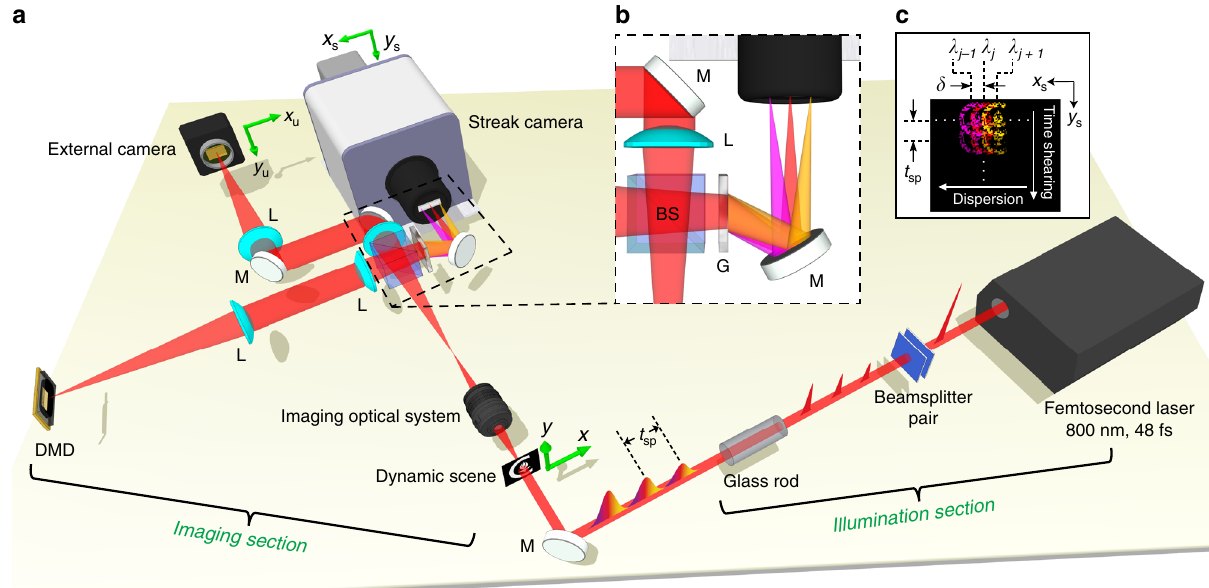
Fig. 1 Schematic of the active CUSP system for 70-Tfps imaging. a Complete schematic of the system. The beamsplitter pair followed by a glass rod converts a single femtosecond pulse into a temporally linearly chirped pulse train with neighboring sub-pulses separated by t according to the experiment. b Detailed illustration of the spectral dispersion scheme (black dashed box). c Composition of a raw CUSP image in s -View, which includes both spectral dispersion by the grating in the horizontal direction and temporal shearing by the streak camera in the vertical direction. BS, beamsplitter; DMD, digital micromirror device; G, diffraction grating; L, lens; M, mirror. Equipment details are listed in the “ Methods ”